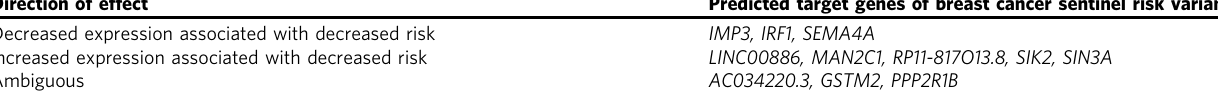
Predicted target genes of breast cancer sentinel risk variants